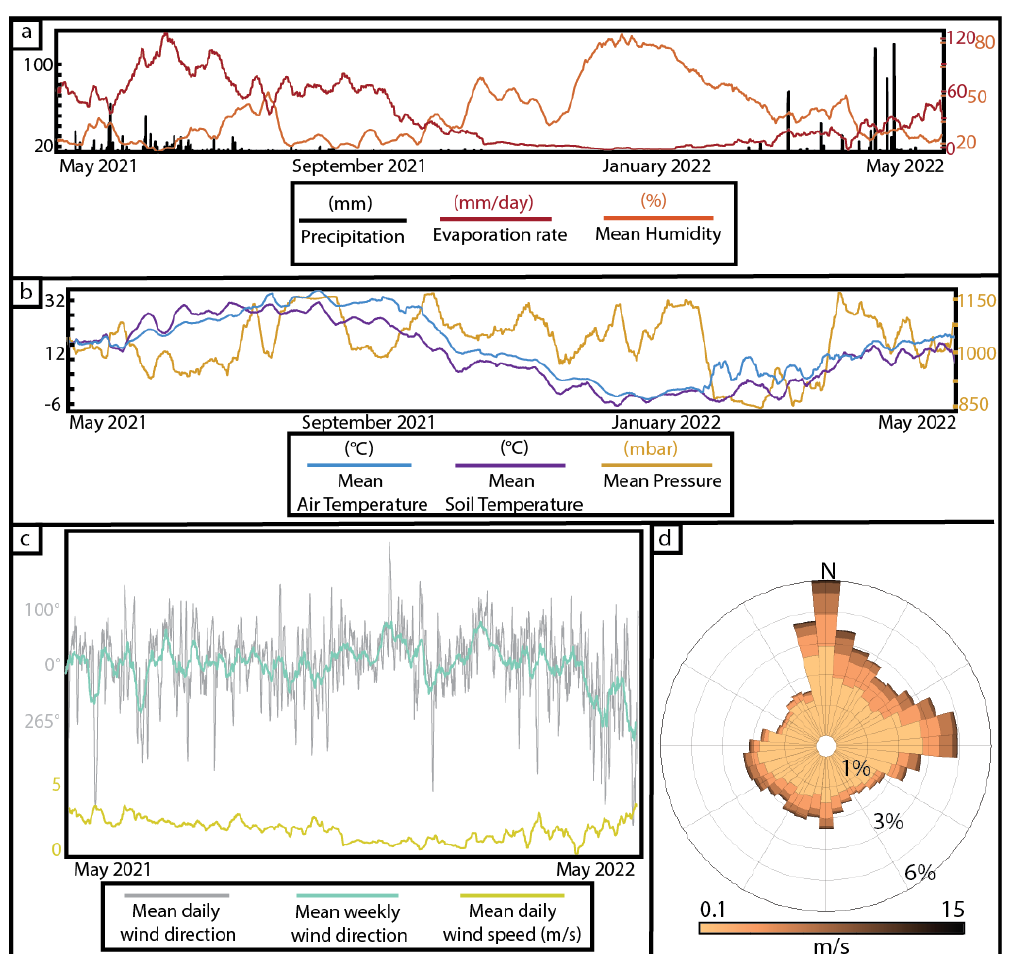
Figure 2. Weather in Deep Springs, CA, between 1 May 2021 and 11 May 2022. (a, b) The 1min interval weather data. Precipitation is greatest during the spring and is dormant during the summer through winter. Soil and air temperatures follow the same general trend with soil temperatures lagging behind air temperatures by ∼ 2 weeks. Humidity is at its greatest during the late fall and winter. (c) Time series of all wind directions and wind speeds experienced in Deep Springs playa. (d) Wind rose diagram showing predominantly northerly to easterly winds in Deep Springs. Wind rose shows all wind speeds in Deep Springs greater than 0.1ms − 1 . Along with a majority of the winds in Deep Springs emanating from the north to the east, higher wind speeds also primarily emanate from these same